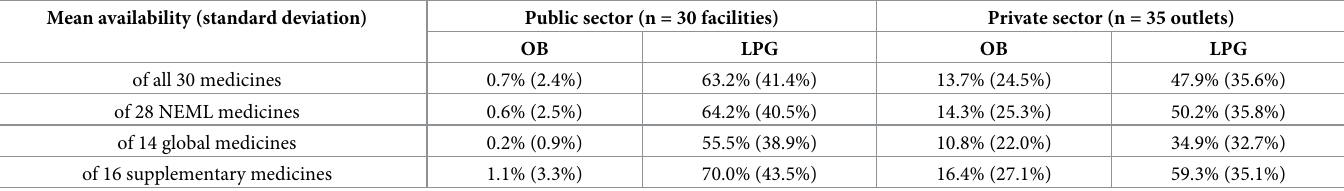
Table 2. The mean availability of medicines on the day of data collection.